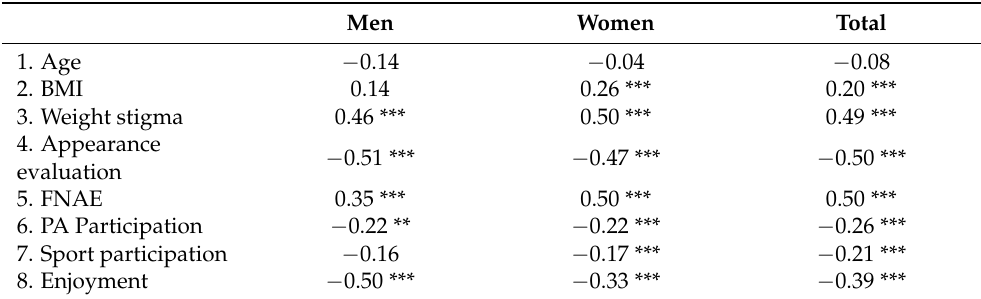
Table 3. Pearson’s product moment correlations between TAPAS and measures of weight stigma and appearance concerns for men and